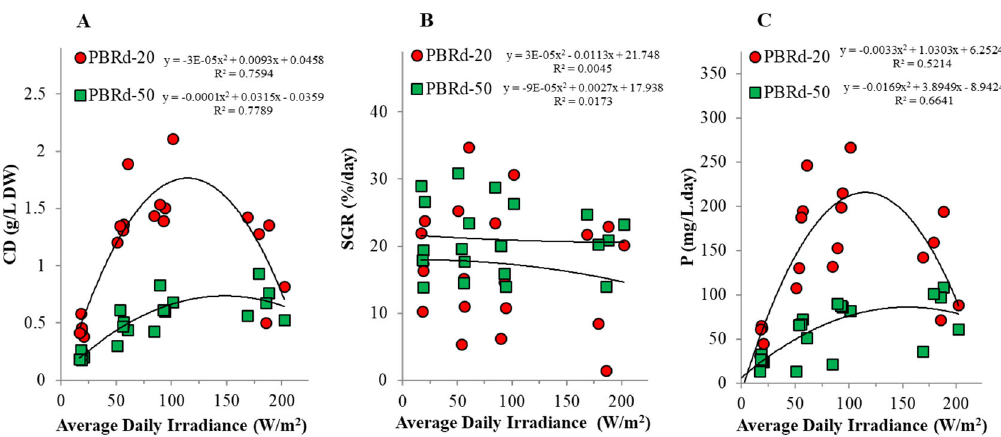
Figure 4. Response of outdoor A. platensis culture cell density ( A ), specific growth rate ( B ), and bio ‐ mass productivity ( C ) to natural daily irradiances in a tropical area.